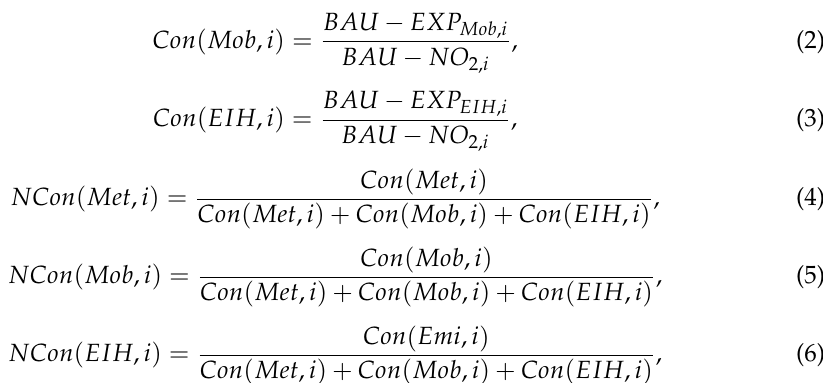
Table 2. Design of the sensitivity experiments. Experiment Description The simulated NO 2 concentrations in RF model run with meteorological EXP Met,i variables in i 1 period and other variables in 2019. The simulated NO 2 concentrations in RF model run with variables about road EXP Mob,i traffic in i 1 period and other variables in